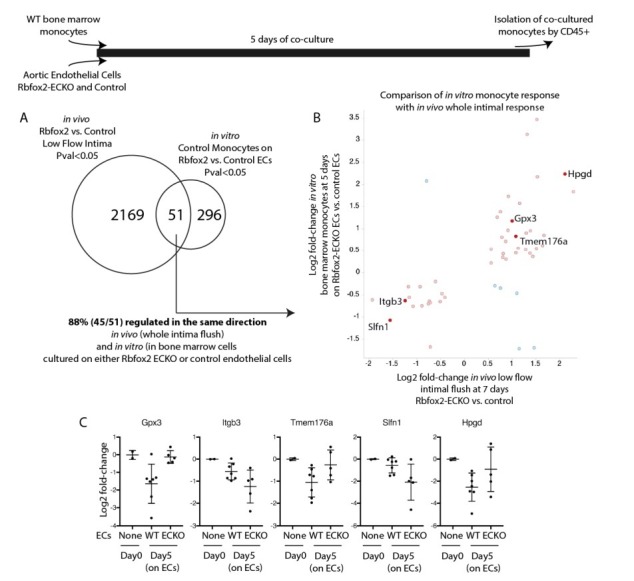
Endothelial cells deficient in Rbfox2 alter the response of co-cultured monocytes and replicate aspects of the in vivo intimal response.Wild-type bone marrow monocytes were isolated and cultured for 5 days on Rbfox2-ECKO or control aortic endothelial cells (N=5 and N=7). Transcriptome of the initial monocytes and the co-cultured monocytes was analyzed by RNA-seq. (A) Overlap of the genes with pvalue<0.05 by DESeq2 with the genes identified by the same threshold in vivo. (B) Comparison of the fold-change observed in vitro, in co-cultured monocytes, and in vivo, in the intimal flush of low-flow carotid arteries. In red/pink are genes concordant in both, in blue are genes with opposing changes in vivo and in vitro. (C) Log2 fold-change (relative to the input monocytes at Day0) in monocytes cultured on biological replicates of Rbfox2-ECO or WT aortic endothelial cells.